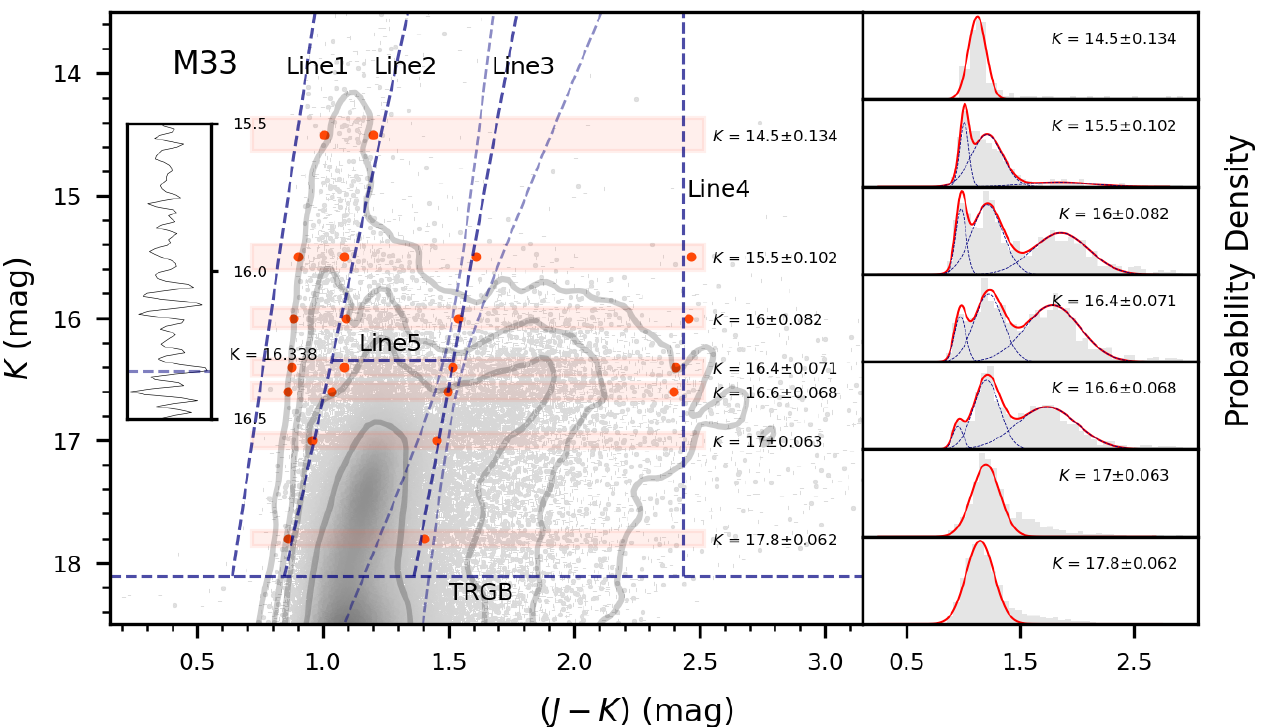
Figure 1. Determination of the borderlines between different types of stars in the ( J − K ) 0 / K 0 diagram in the LMC and M33. The boundaries (red dots) of each magnitude cut (red masks) calculated from GMM fitting (right panels), are used to fit the borderlines (dashed line). The dashed lines on either side of Line 3 represent the location of its 50% confidence interval. The insert panels show the reference for detecting the K magnitudes borderlines (Line 5) between O-AGBs and TP-AGBs with the Sobel